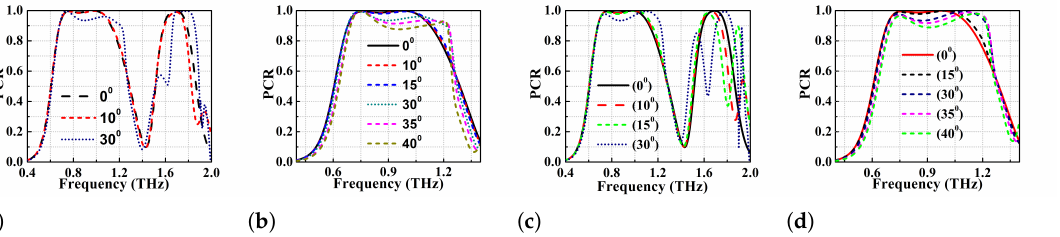
Figure 13. Oblique angle stability analysis of the dual band PC ( a ) TE mode ( b ) TE mode for 1st band ( c ) TM mode ( d ) TM mode for 1st